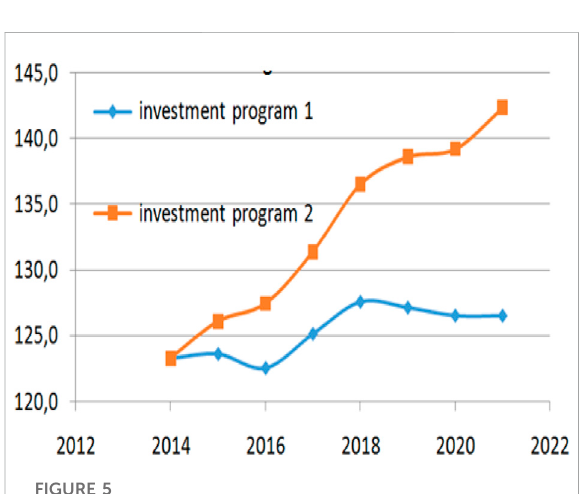
FIGURE 5 ModellingofInnovationindexdynamicsinclimatechangefor two investment programs in 2014 – 2021 in Belgium.